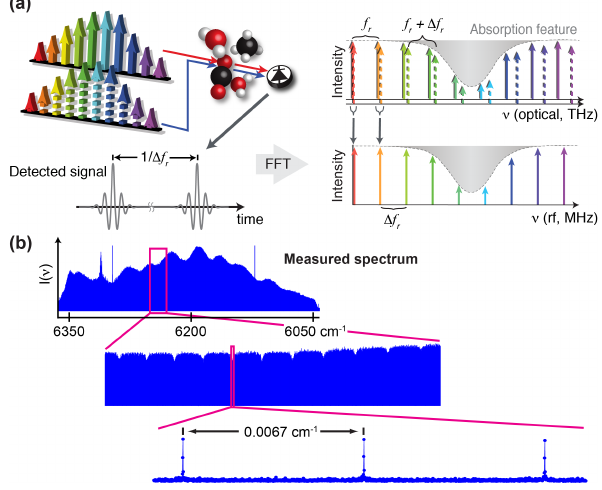
Figure 1. (a) In dual-comb spectroscopy two frequency combs (solid and dashed) are phase-locked together with slightly differ- ent comb tooth separation (e.g., pulse repetition rates) of f r and f r + (cid:49)f r as seen on the right-hand side. The combs pass through a gas sample and are heterodyned on a detector to generate a sig- nal. In the time domain (left hand side), this signal is a series of interferograms, similar to Fourier transform spectroscopy, whose Fourier transform yields a spectrum. In the frequency domain (right- hand side), each individual pair of comb teeth yields a RF hetero- dyne signal with an amplitude equal to the product of the comb teeth. Because of the Vernier-like offset in repetition rates, the RF frequency generated by each pair of optical teeth is distinct, giv- ing a one-to-one mapping between RF comb teeth and optical fre- quency comb teeth. As a result, the x axis of the measured RF spectrum can simply be scaled to generate the optical spectrum. A more detailed explanation is given in Coddington et al. (2008). (b) Actual spectrum from DCS A acquired in 1.15s after transmis- sion through a 2km air path. The overall shape is governed by the comb spectrum, but there are narrow absorption dips present from atmospheric gases, as shown in the first expanded view. The sec- ond expanded view shows the fully resolved RF comb teeth with time–bandwidth-limited widths. The highly resolved nature of these spectral elements follows the illustration in (a) and reflects the neg- ligible instrument line shape, set by the narrow comb line widths. Here, each RF tooth represents an optical sample with a separation of 0.0067cm − 1 (or f r = 200MHz). For longer acquisition times, we implement coherent co-adding of interferograms that maintains this precise optical sampling of the absorbance spectrum (Codding- ton et al.,